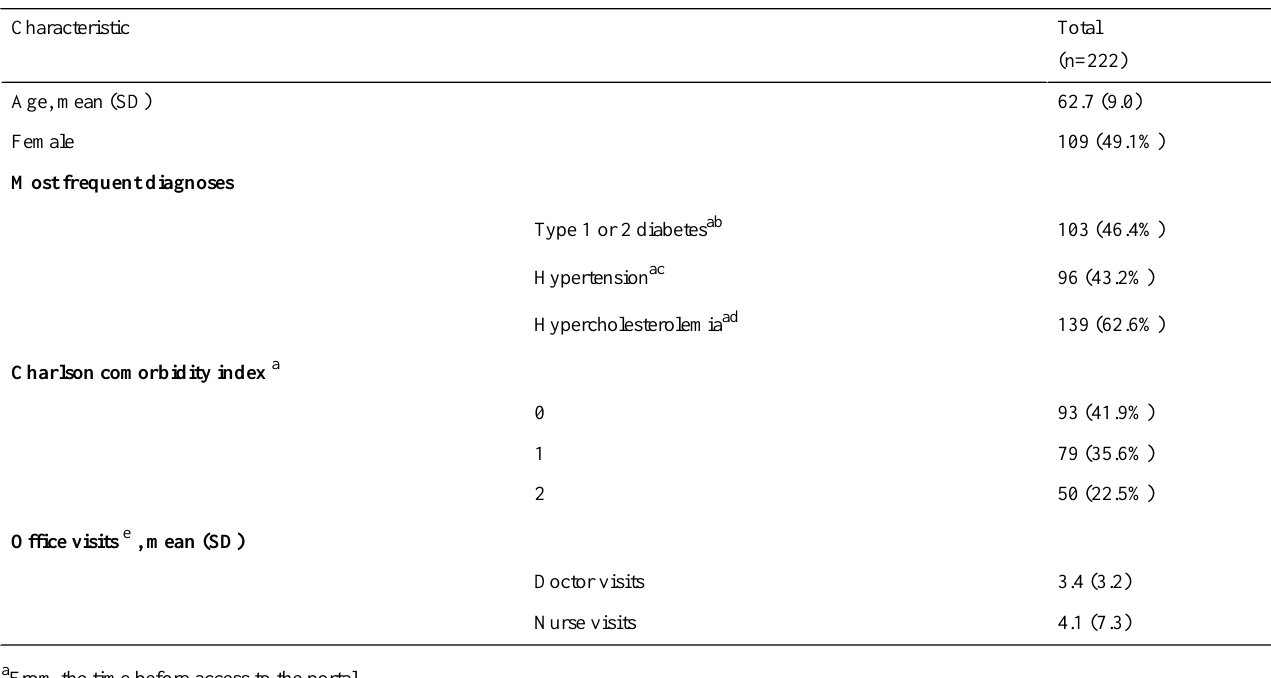
Table 1. Descriptive characteristics of the study participants.